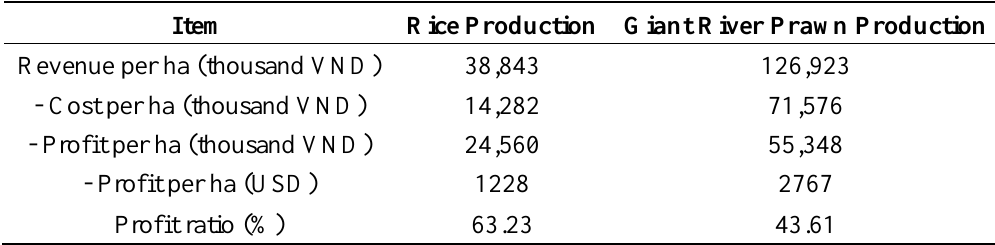
Table 2. Comparative analyses of revenues, costs and profits of rice and aquaculture production. Item Rice Production Giant River Prawn Production Revenue per ha (thousand